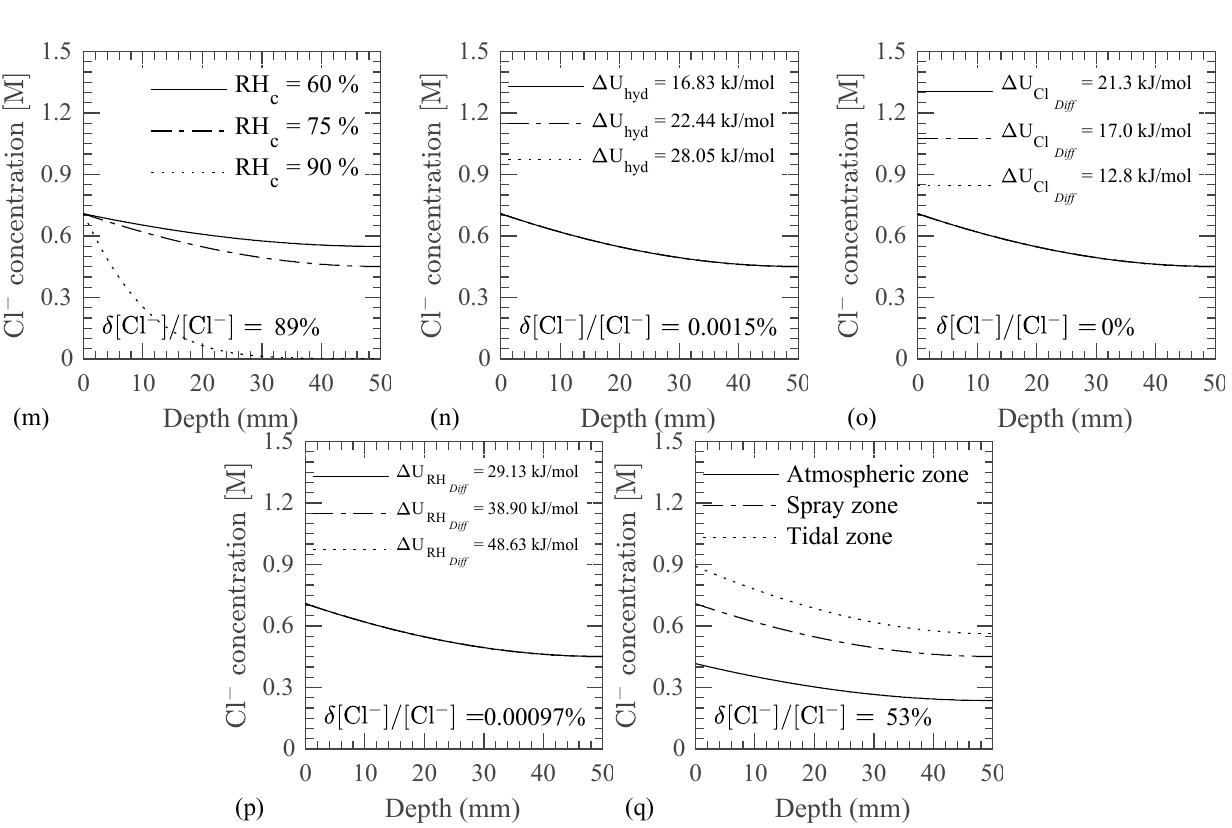
Figure 7. Effect on Cl − transport of varying ( a ) cement type; ( b ) aggregate type; ( c ) w/c ratio; ( d ) air content, a c ; ( e ) aggregate- to-cement (a/c) ratio; ( f ) curing duration, t cu ; ( g ) RH during curing, RH cu ; ( h ) temperature during curing, T cu ; ( i ) exposure duration, t exp ; ( j ) RH during exposure, RH exp ; ( k ) temperature during exposure, T exp ; ( l ) Cl − diffusivity in capillary water at 298 K, D cw ; ( m ) critical RH, RH c ; ( n ) activation energy for cement hydration, ∆ U hyd ; ( o ) activation energy for Cl − diffusion, ∆ U Cl Diff ; ( p ) activation energy for RH diffusion, Δ U (cid:2902)(cid:2892) ; and ( q ) exposure zone with different surface Cl − concentration.